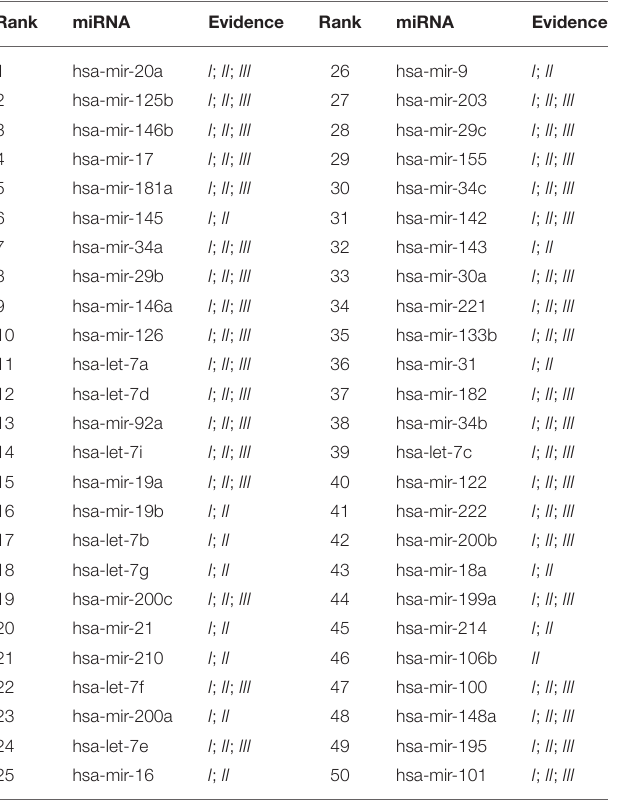
TABLE 6 | Top 50 predicted miRNAs related to Kidney Neoplasms based on HMDD v2.0.